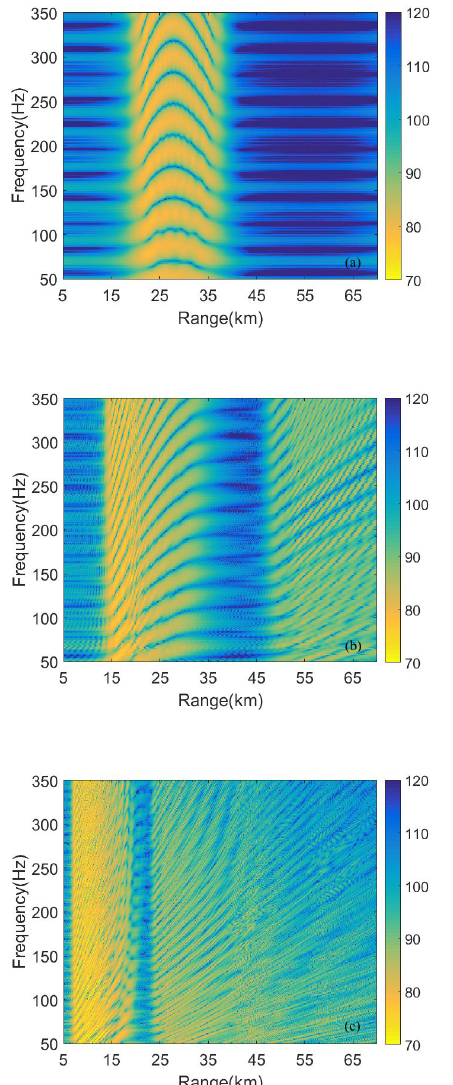
Figure 6. Intensity according to phase speed intervals in Figure 5. ( a ) Phase speed < 1567.3 m/s; ( b ) 1567.3 m/s < phase speed < 1600 m/s; ( c ) 1600 m/s < phase speed < 1800 m/s.